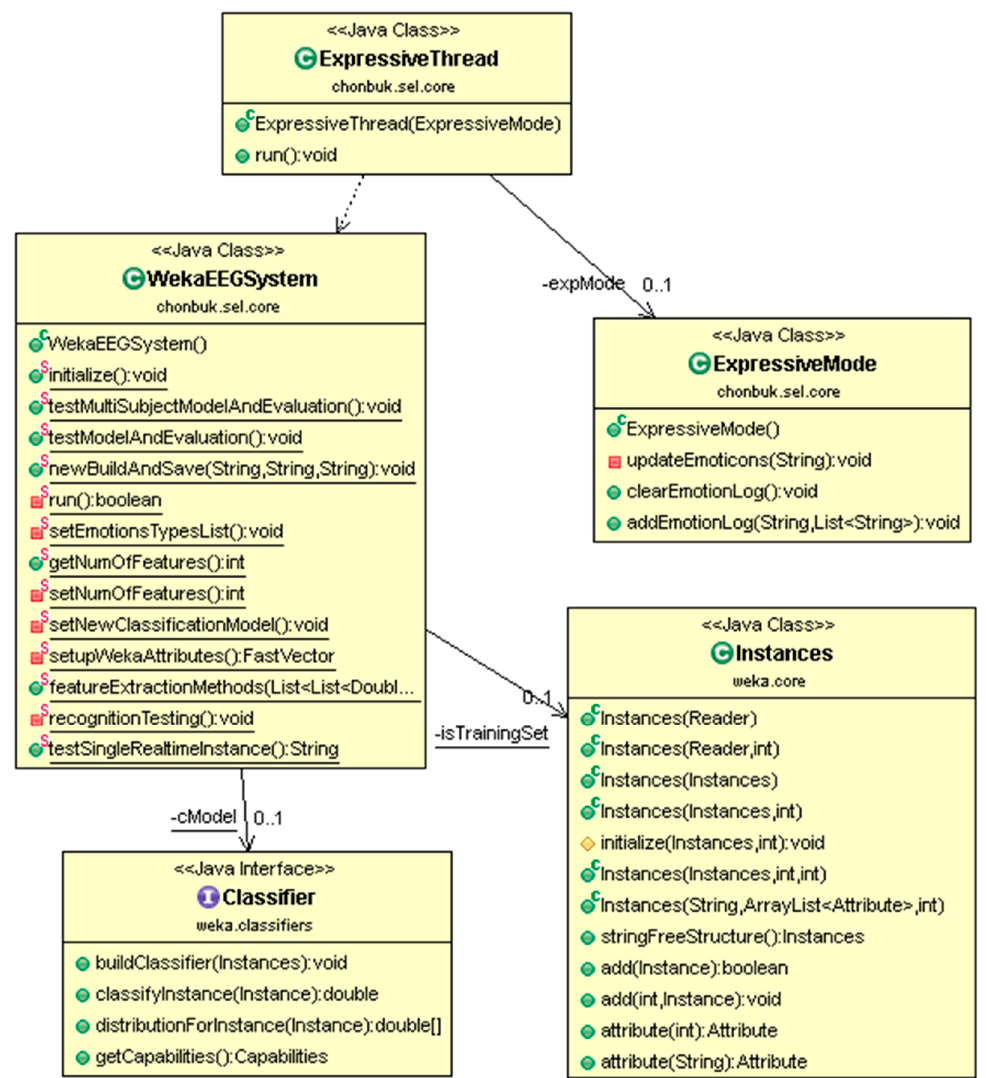
Figure 6. Class diagram contains class structure of emotion recognition module which has linking with WEKA for emotion classification.